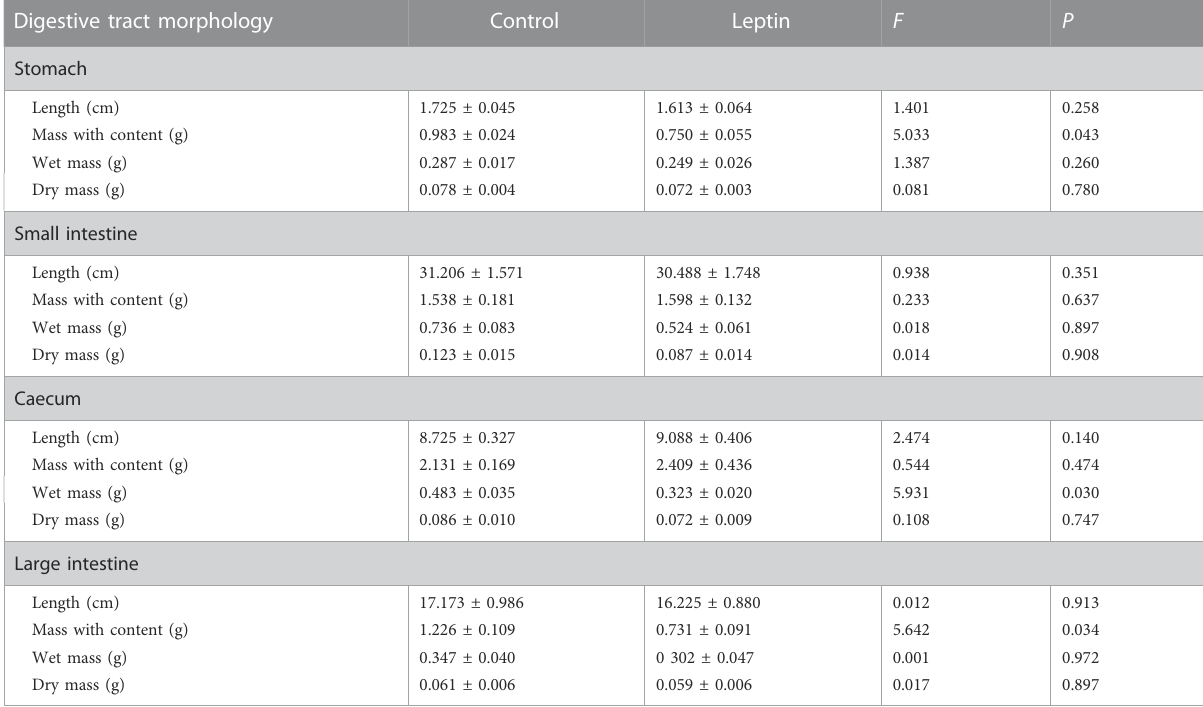
TABLE 2 Effects of leptin on the morphology of digestive tract in Eothenomys miletus. Digestive tract